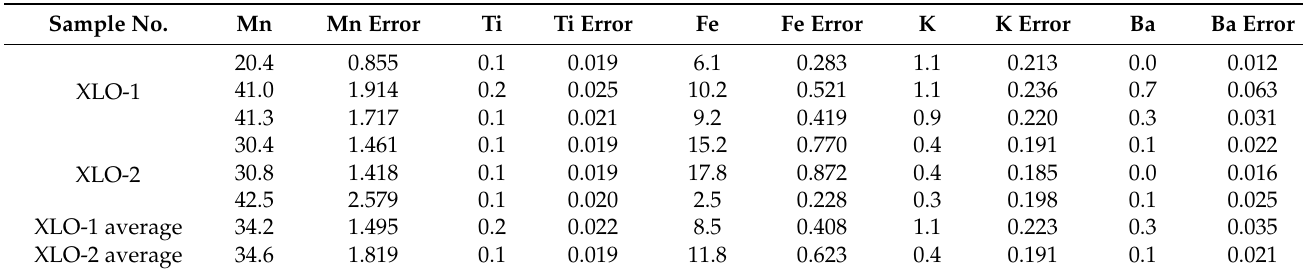
Table 1. Chemical composition of the two Mn oxide samples (XLO-1, XLO-2) from the Xialei deposit by X-Ray Fluorescence (in wt.%). Sample